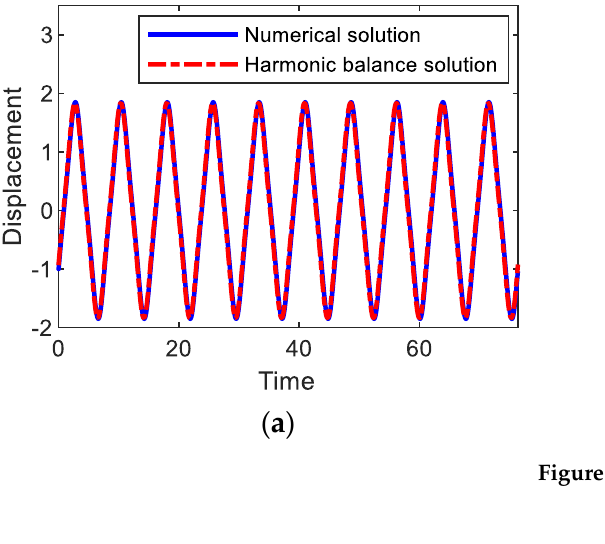
Figure 5. ( first column ) Time responses and ( second column ) the associated amplitude spectra, obtained by the fast Fourier transform. In ( a , b ) the period-1 T motion when A = 0.02 and ω = 0.82, in ( c , d ) the period-3 T motion when A = 0.02 and ω = 1.37, and in ( e , f ) the period-5 T motion when A = 0.02 and ω = 1.65. The base excitation used for this simulation is also presented for comparison. In ( a , c , e ), the red dots indicate the stroboscopic projections of the oscillations, which are synchronized with the period T of the base excitation.